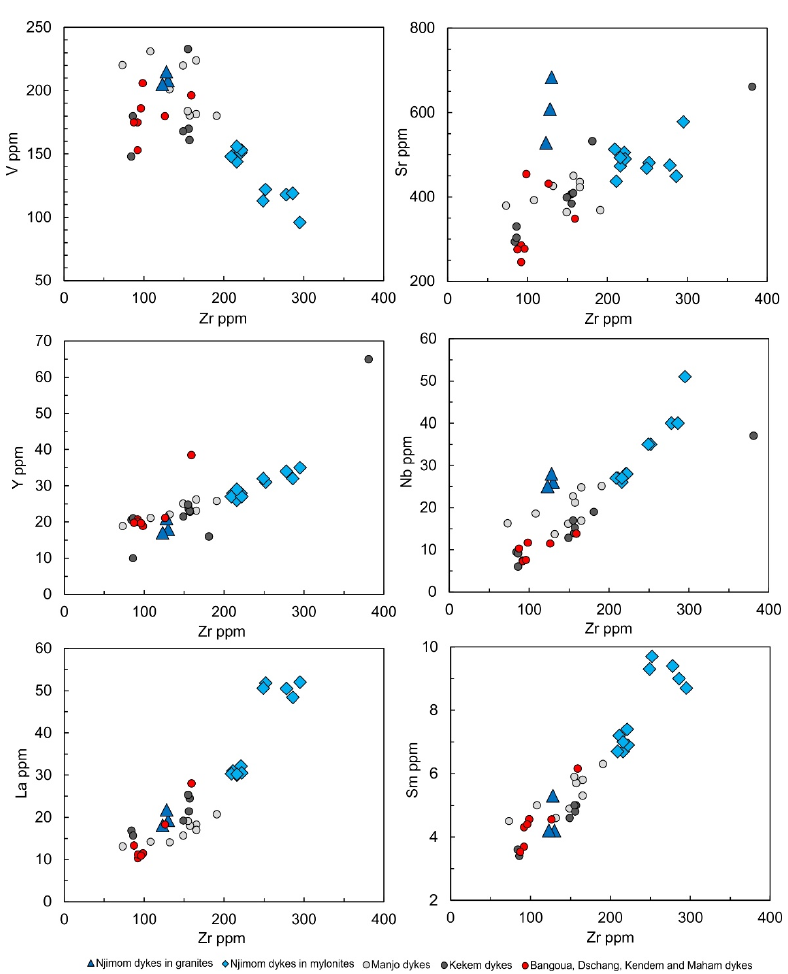
Figure 10. Major and trace element relationships among Njimom dykes. The data for the mafic dyke swarms (Bangoua, Maham, Dschang, Kendem, Manjo, and Kekem) are also shown for comparison [5–7].